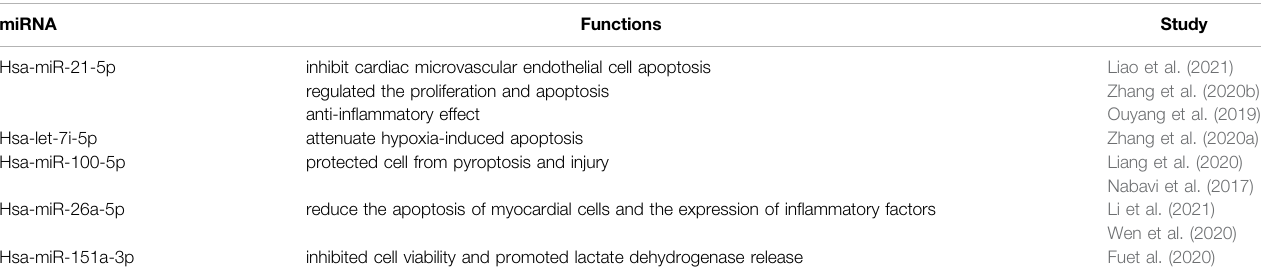
TABLE 1 | List of direct targets of selected miRNAs highly expressed in hRPC-sEVs and their functional role. miRNA Functions